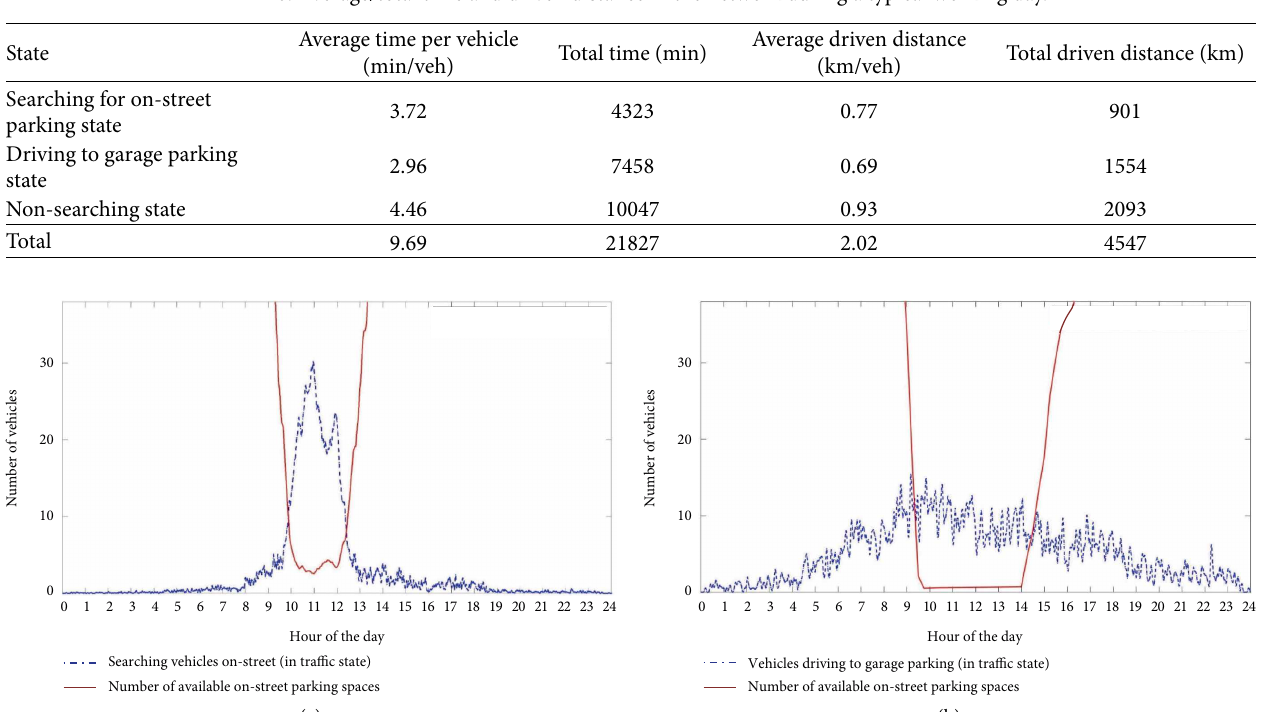
Table 6: Average/total time and driven distance in the network during a typical working day.